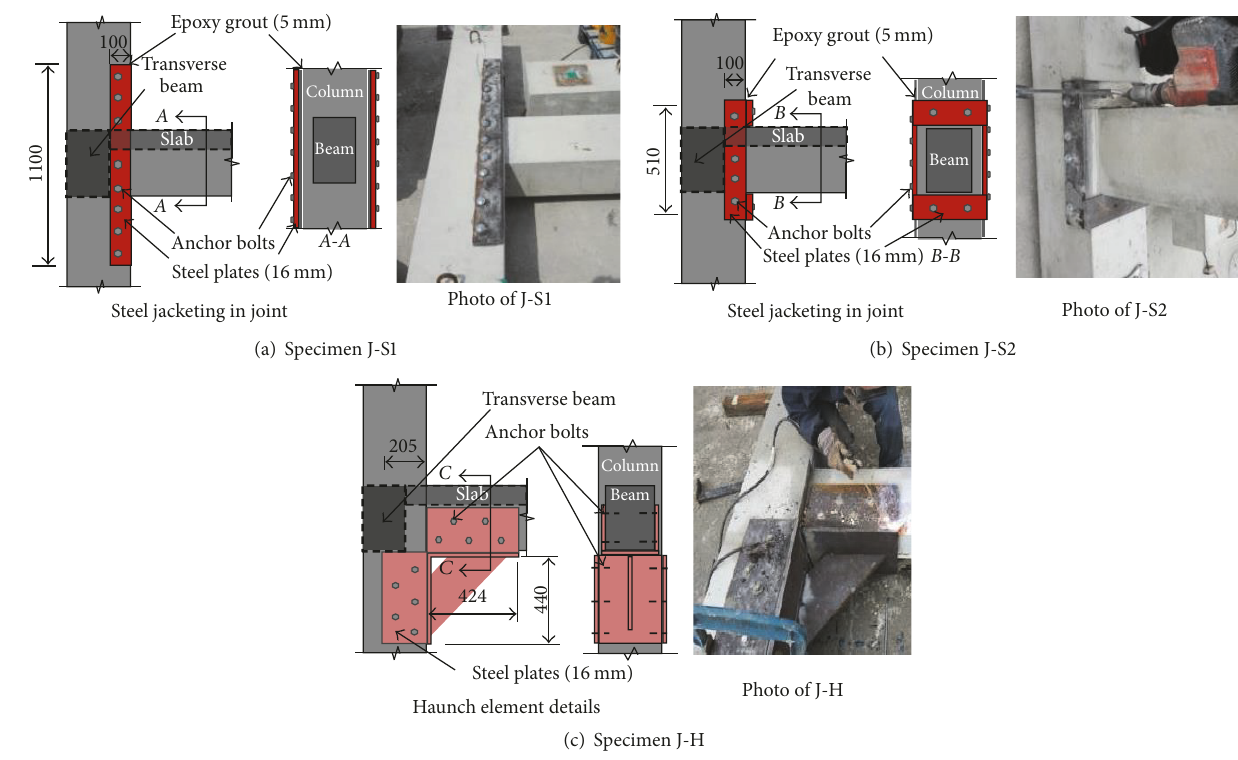
Figure 3: Details of retrofitted